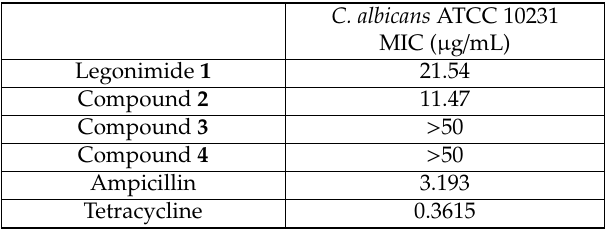
Table 2. Minimum inhibitory concentration of compounds 1 – 4 against C. albicans